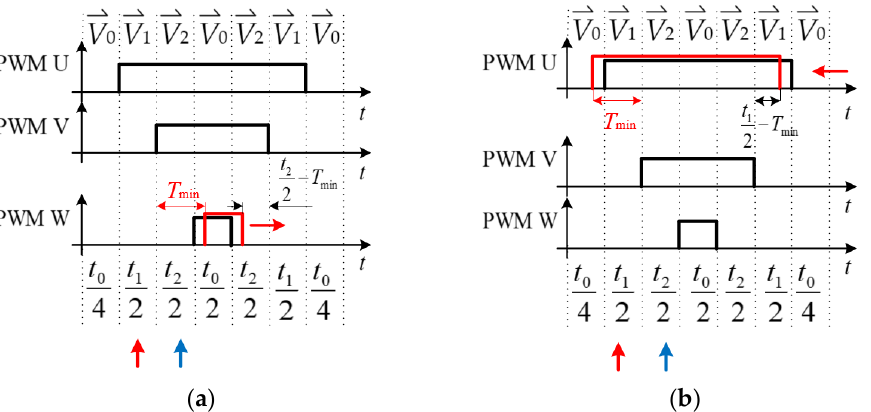
Figure 8. ( a ) SVM modification pattern while t 2 < T min ; ( b ) SVM modification pattern while t 1 < T min . If time t 2 is shorter than T min , the SVM signal with the smallest duty cycle is shifted to the right to ensure enough time for current measurement during vector 𝑉⃑ 2 , as shown in Figure 8a. In case t 1 is shorter than T min , the SVM signal with the largest duty cycle is shifted to the left to ensure enough time for current measurement during vector 𝑉⃑ 1 , as shown in Figure 8b.